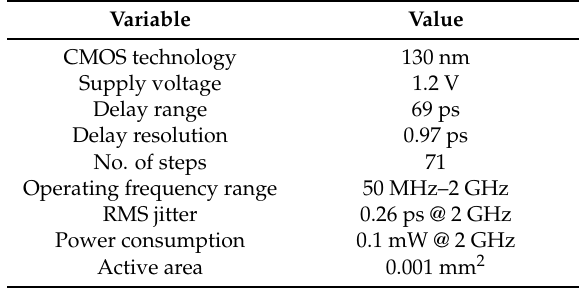
Table 2. Summary of performance specifications and results achieved by the proposed DLL design.